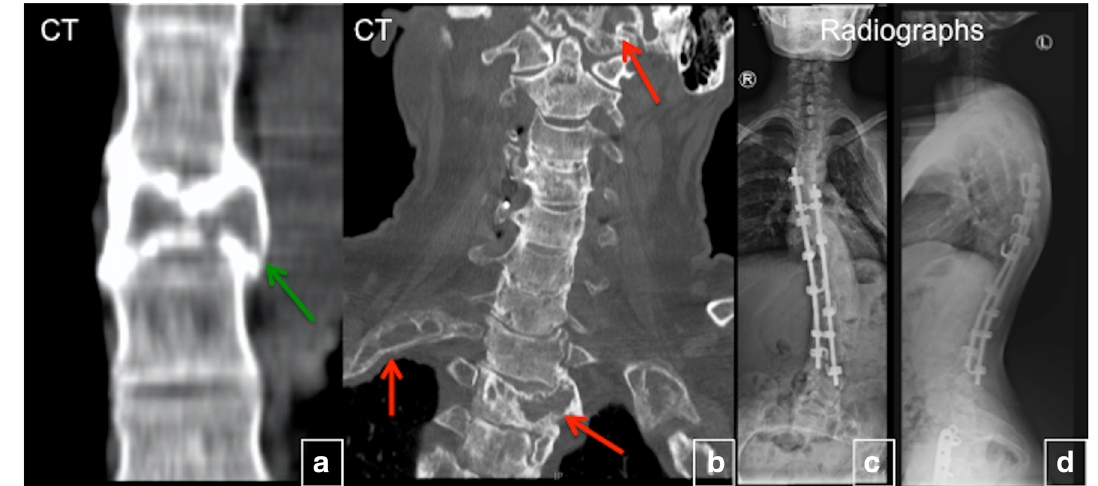
Fig. 22 Fibrous dysplasia (FD) of the spine. a Monostotic FD of the T6 vertebral body complicated by a compression fracture ( green arrow ). b Polyostotic FD involving the spine, ribs and skull ( red arrows ). c , d